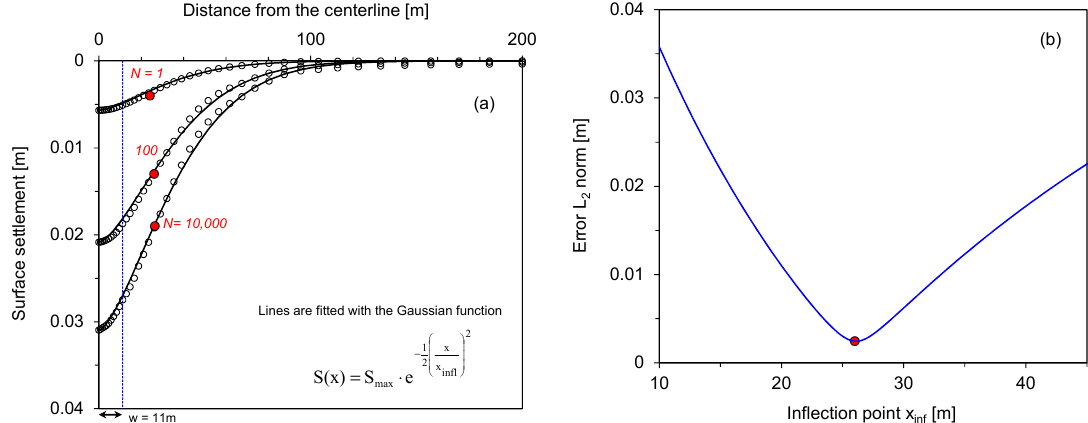
Figure 9. Error minimization analysis on surface settlement profiles for stress cycles N = 1, 100, 10,000—inflection point x infl and maximum settlements S max . Cases: storage location z o = 30 m; storage width w = 11; cyclic internal stress amplitude Δ P/P avg = 10%. ( a ) Evolution of surface settlement at the end of cycles; and ( b ) error surface L2 norm ( N = 100). Red circles indicate inflection point fit with the settlement model that has been widely used in tunnel engineering.